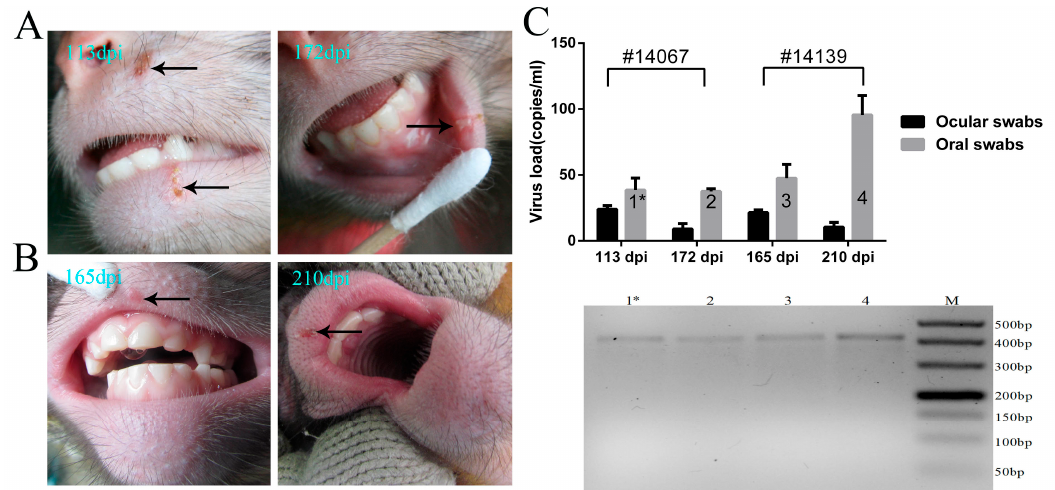
Figure 5. Recurrence of blebs in the oral skin and mucosa within four to five months post ‐ infection. ( A ) spontaneously recurring vesicular lesions on macaque No. 14067 on days 113 and 172; ( B ) spontaneously recurring vesicular lesion on macaque No. 14139 on days 165 and 210; ( C ) oral swabs and ocular swabs were collected from No. 14067 and No. 14139 on recurring vesicular lesion day, and viral shedding was detected; the 1* bar indicates a positive result for viral genomic DNA by PCR in lane 1* (panel below) with primers against UL48 (405 bp); lanes 2, 3 and 4 of PCR electropherograms correspond to 2, 3 and 4 of the graph above, respectively (panel above).